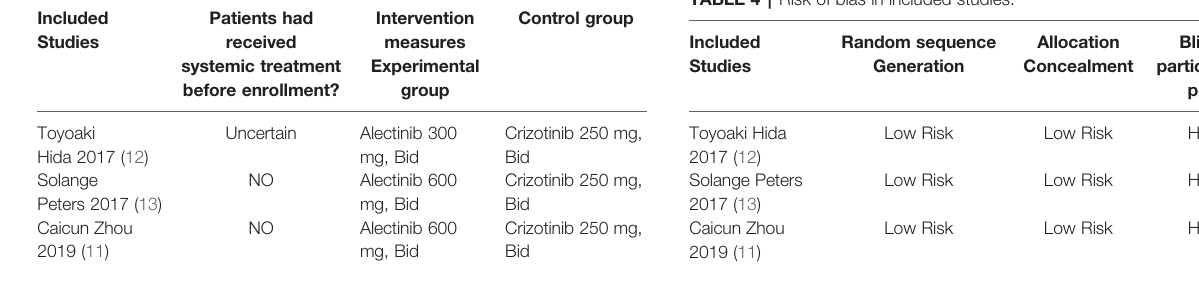
TABLE 4 | Risk of bias in included